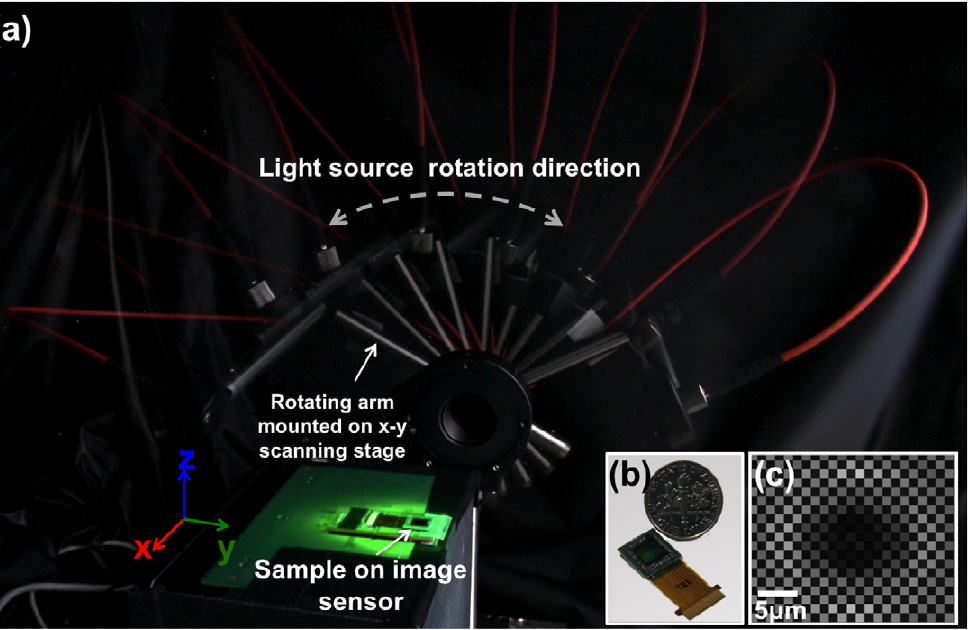
Figure 1. Giga-Pixel Lensfree Holographic Microscopy and Tomography setup. (a) Shows a multi-exposure photograph of the lensfree optical tomography setup employing a colour image sensor. An optical fibre attached to a rotation stage delivers partially-coherent light to the sample, placed on the sensor, at different angles. The light source is also translated laterally using scanning stages to perform pixel super-resolution at each illumination angle. (b) Shows the photograph of the colour image sensor chip. The protective glass, colour filters and the microlens-array on the active area of the sensor remain intact. (c) Shows a cropped lensfree hologram image to demonstrate the Bayer colour filter pattern.